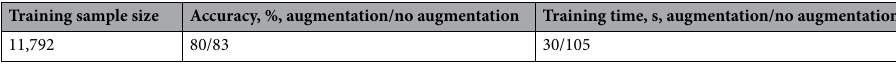
Table 1. Comparison of classification accuracy with and without data